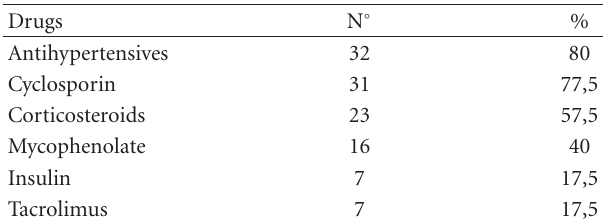
Table 2: Main drugs